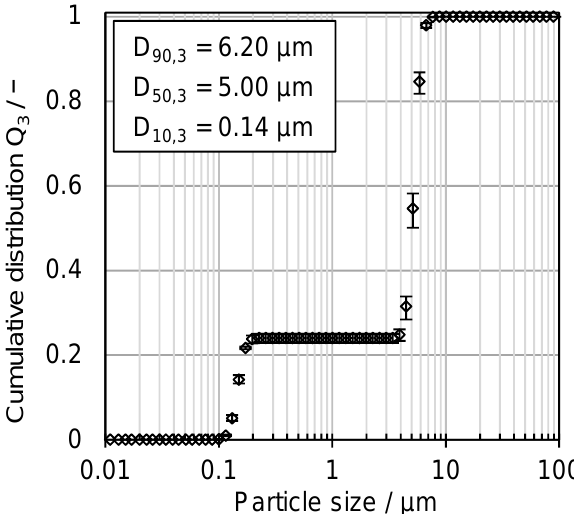
Figure 1. Volume-related particle size distribution Q 3 of the used precipitated.